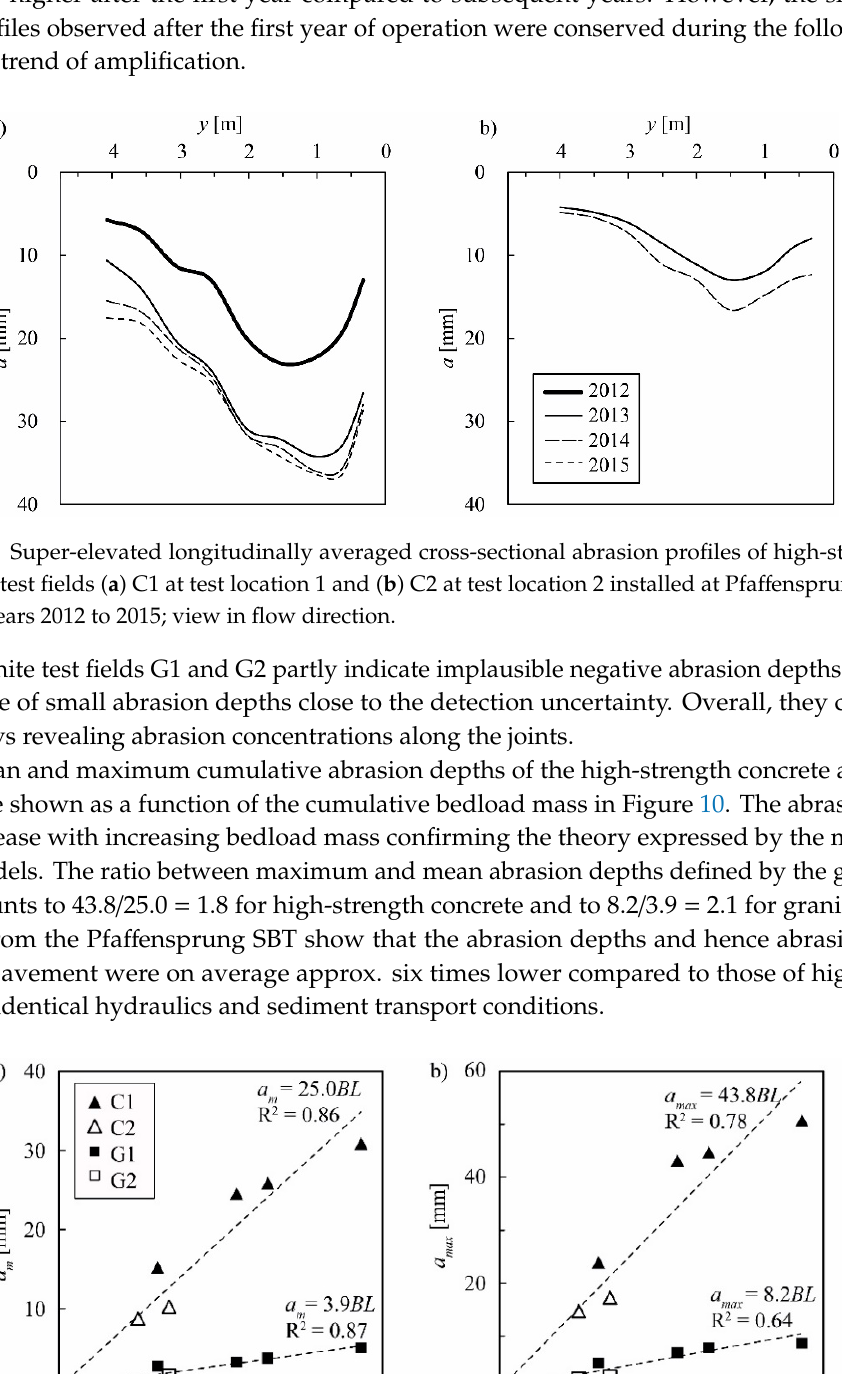
Figure 10. ( a ) Mean and ( b ) maximum cumulative abrasion depths as a function of cumulative bedload mass at Pfaffensprung SBT for high-strength concrete test fields C1 and C2 and granite test fields G1 and G2 for the years 2012 to 2015.